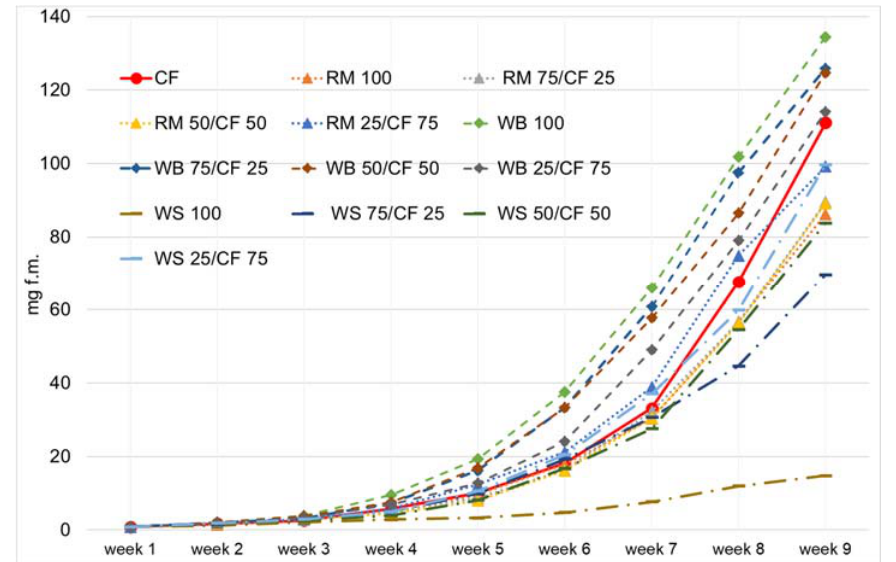
Figure 1. Individual larvae weight depending on the type of diet and week of rearing; CF (chicken feed), RM (rapeseed meal), WB (wheat bran) and WS (willowleaf sunflower).